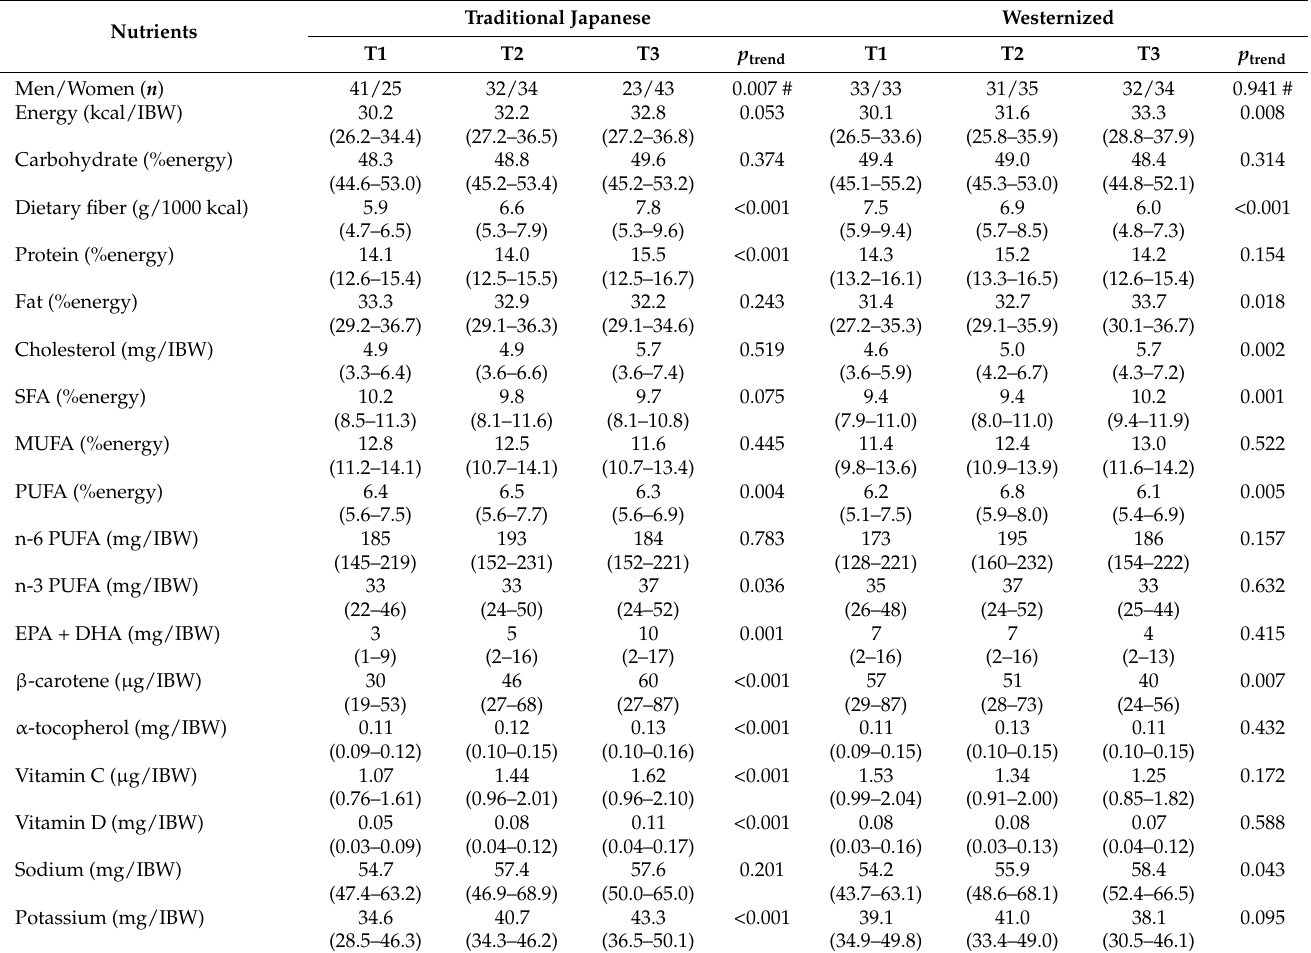
Table 4. Energy and nutrient intakes according to tertiles of the two food intake pattern